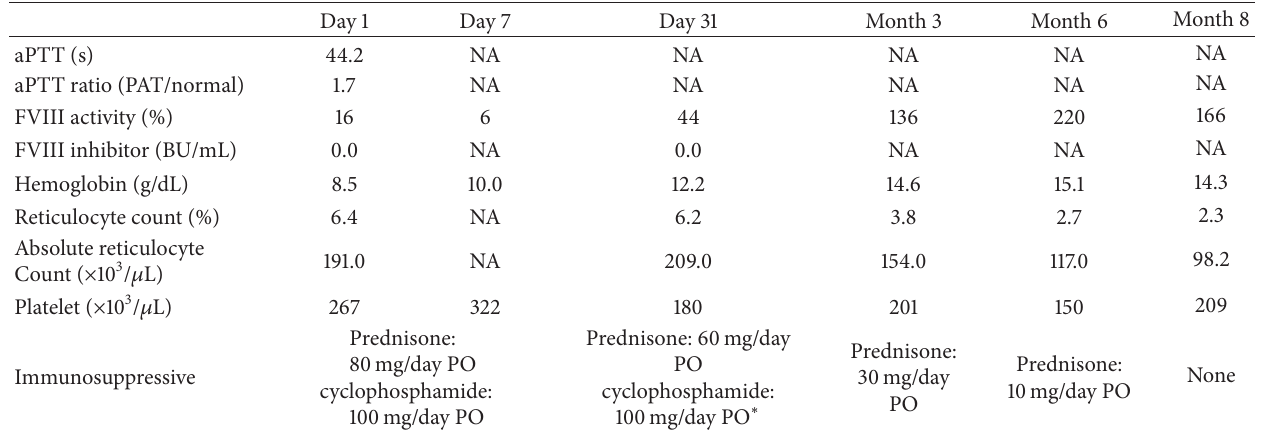
Table 2: The laboratory data and clinical course of acquired hemophilia